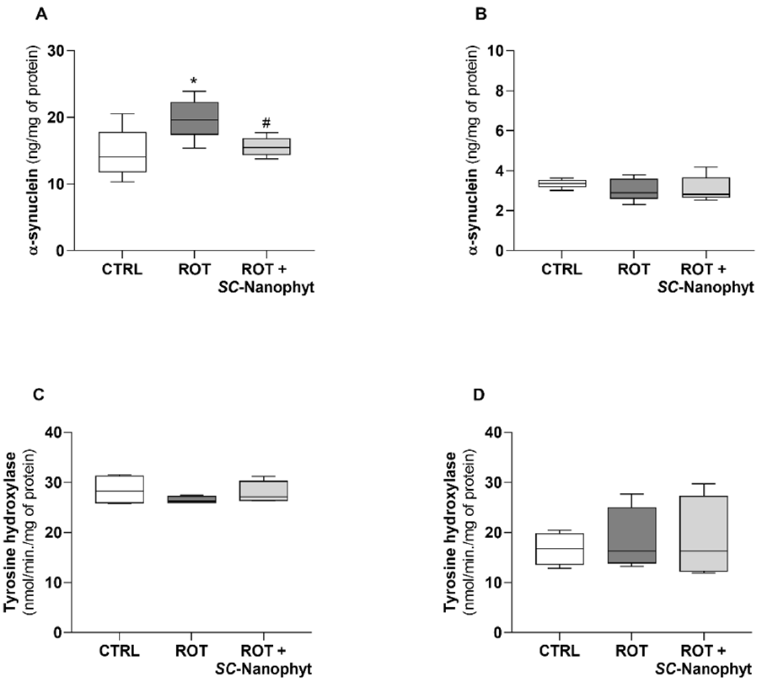
Figure 3. Brain α -synuclein levels assessed in brain homogenates from BG-Cereb ( A ) and the C- Cortex ( B ) portions of the CTRL, ROT, and ROT + SC -Nanophyt groups. The results are expressed as ng/mL/mg of protein. Tyrosine hydroxylase activity was assessed in the mitochondria-free cytosolic fraction from BG-Cereb ( C ) and the C-Cortex ( D ) portions of the CTRL, ROT, and ROT + SC -Nanophyt groups. The results are expressed as nmol/min/mg of protein. Error bars represent SEM for n = 5 independent experiments using five animals in each one. * Significantly different from the CTRL group, with p ≤ 0.05. # Significantly different from the ROT group, with p ≤ 0.05.